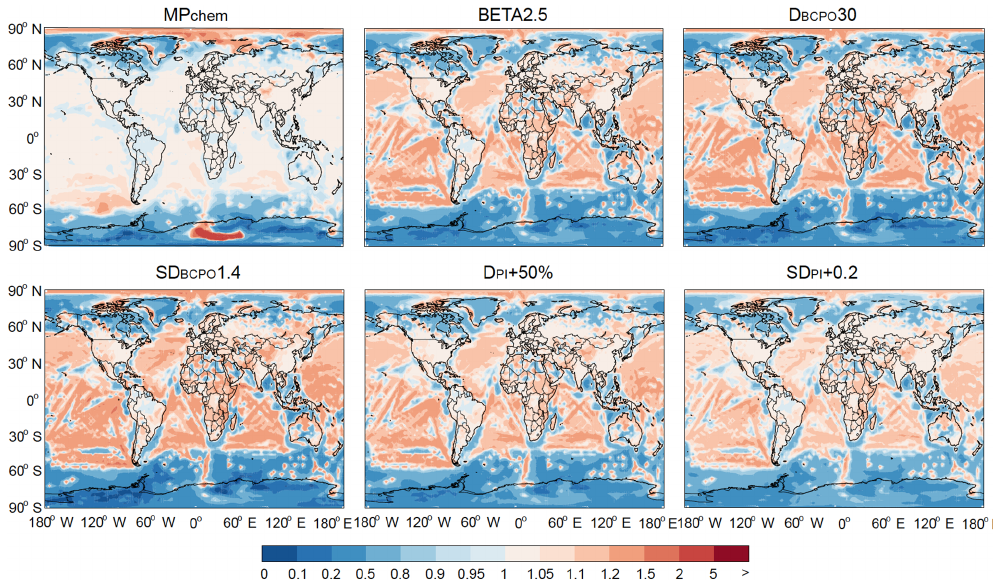
Figure 11. GEOS-Chem simulated ratios of annual mean BC aging rate from six microphysics-based simulations (Table 1) to that from the standard microphysics-based simulation in the surface layer. See Table 1 and text for details. Model results are for